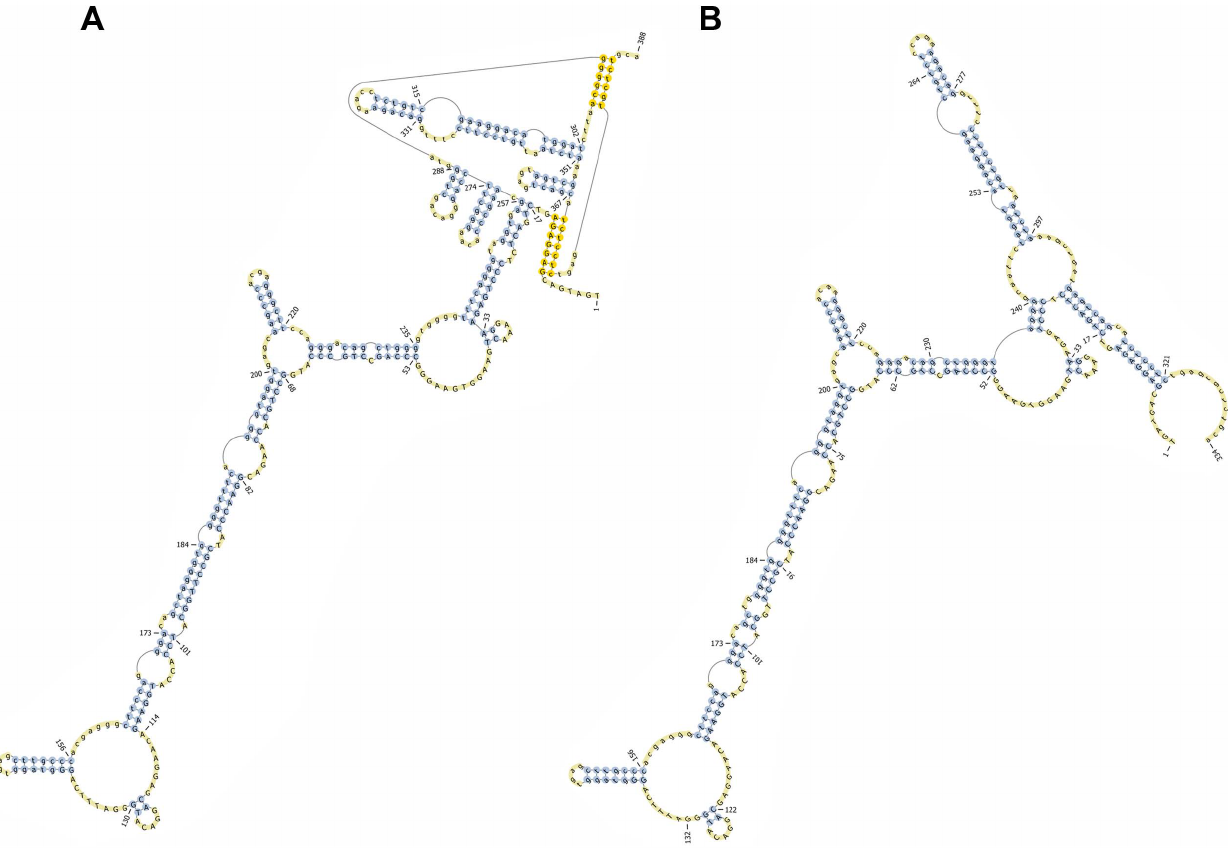
Figure 4. Secondary structure prediction of Nf k b1 pre-mRNAs produced by AJ and B6 copy number variant. The pknotsRG tool [77] was used to generate secondary structures for the 350 nucleotides segment spanning the 3-repeat structure of B6 ( A ) and the deletion variant characteristic of A/J ( B ). Unpaired bases are indicated in blue, yellow bases identifying nucleotides involved in pseudoknot structures. This analysis identifies a pseudoknot with elaborate intra-molecular complementarity which is disrupted in the A/J variant allele.